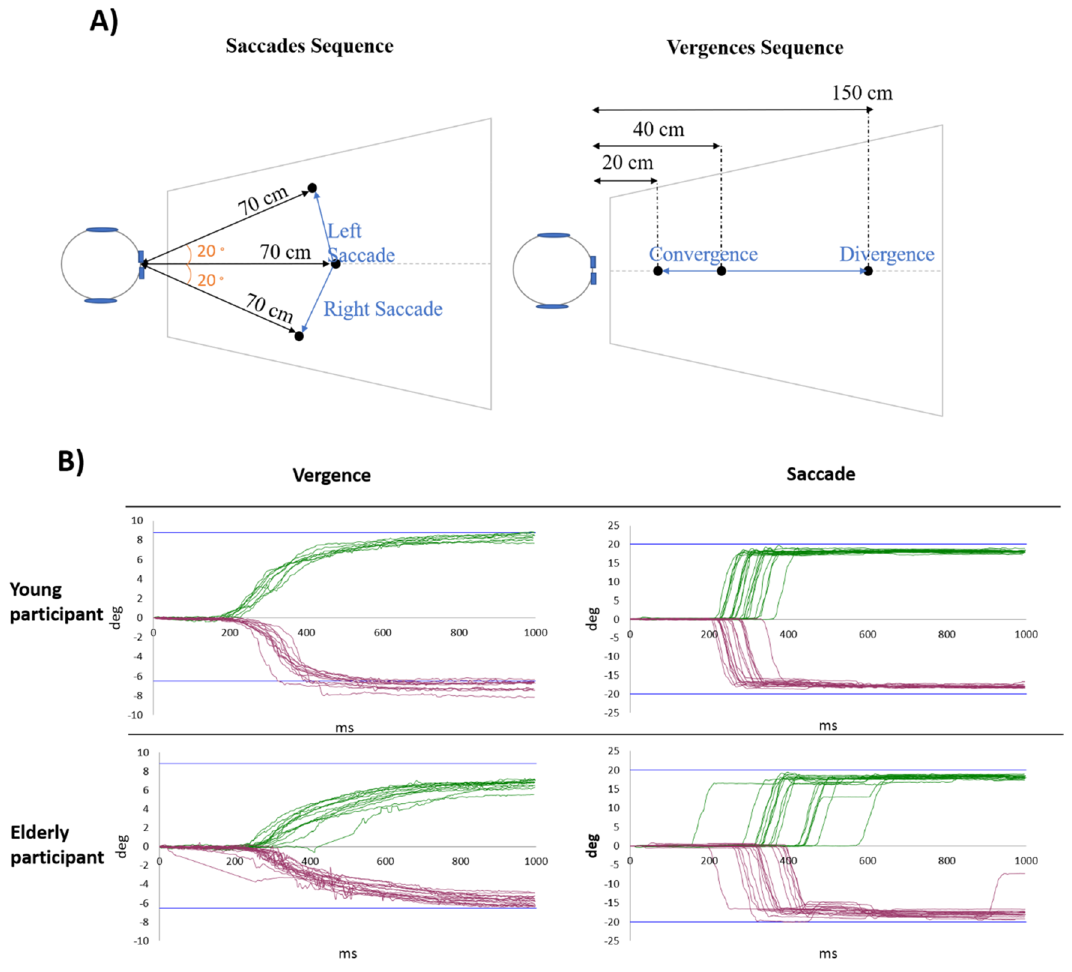
Figure 4. ( A ) Top-view of the position of the LEDs for the saccades sequence (on the left) and for the vergence sequence (on the right). ( B ) Graphic produced by the AIDEAL software, permitting a quick overview of the results for vergence and saccades sequences. The two graphs on the top represent the results for a young adult participant, while the two graphs on the bottom represent the results for an elderly participant. Each curve represents the rotation of the eyes (in degrees on the Y-axis) in function of time (in ms on the X-axis), made during one trial, from the fixation LED to the target LED (0° means that the participant is still looking at the fixation LED). For the vergence sequence, the green upper curves represent the convergence movements and the purples lower curves represent the divergence movements. For the saccade sequence, the green upper curves represent the right saccade movements, and the purple lower curves represent the left saccade movements. The blue lines represent the amplitude required to reach the fixation LED: − 6.50° for the divergence, 8.76° for the convergence, − 20° for the left saccade and 20° for the right